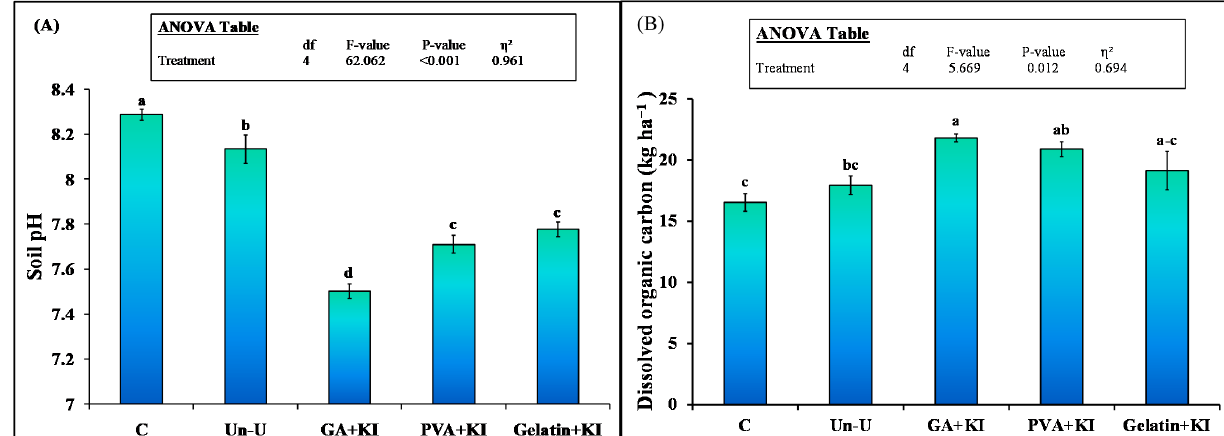
Figure 4. Mean (n = 3) Soil pH ( A ) and dissolved organic carbon ( B ) after 200 days of the application of uncoated and coated urea fertilizers. Abbreviations of fertilizer treatments can be seen in Figure 1. Different small letters illustrated significant differences among treatments at a 5% probability level after the Tukey ‐ HSD test. C stands for untreated control treatment. Error bars showed standard errors (±1 SE) of the mean. Inset table represented the outcomes of analysis of variance (ANOVA).